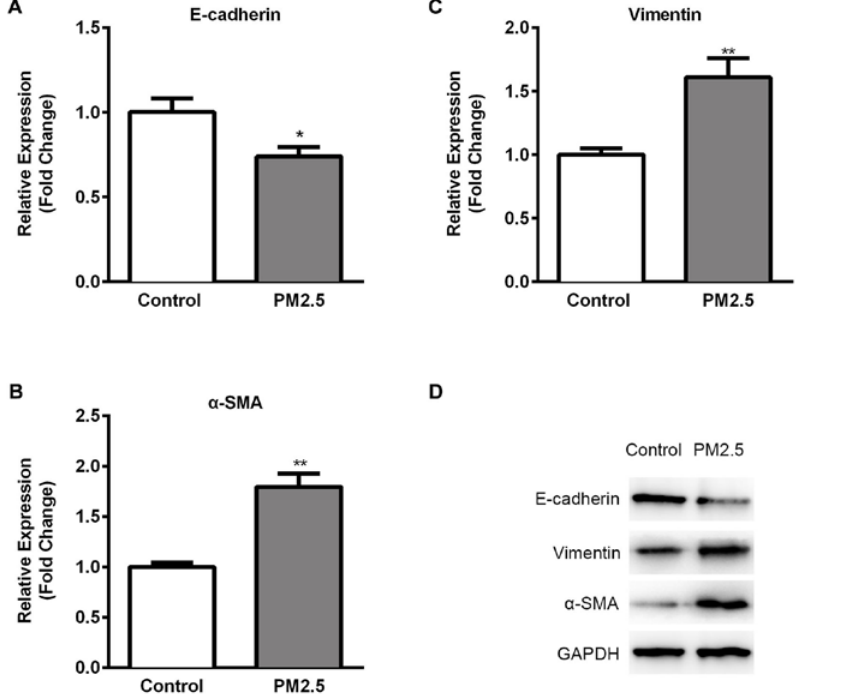
Figure 3: Potential of PM2.5 exposure on EMT in SMMC-7721 cells RT-qPCR was performed on (A) E-cadherin (B) Vimentin (C) ɑ-SMA expressions in PM2.5 treated SMMC-7721 cells in comparison to untrea- ted cells. Results were normalized with the level of GAPDH control. (D) The expression levels of EMT related proteins were analyzed using Western blotting assay. GAPDH was used as the loading control. Data are presented as means ± SD. of three independent experiments. *, p < 0.05, **, p <